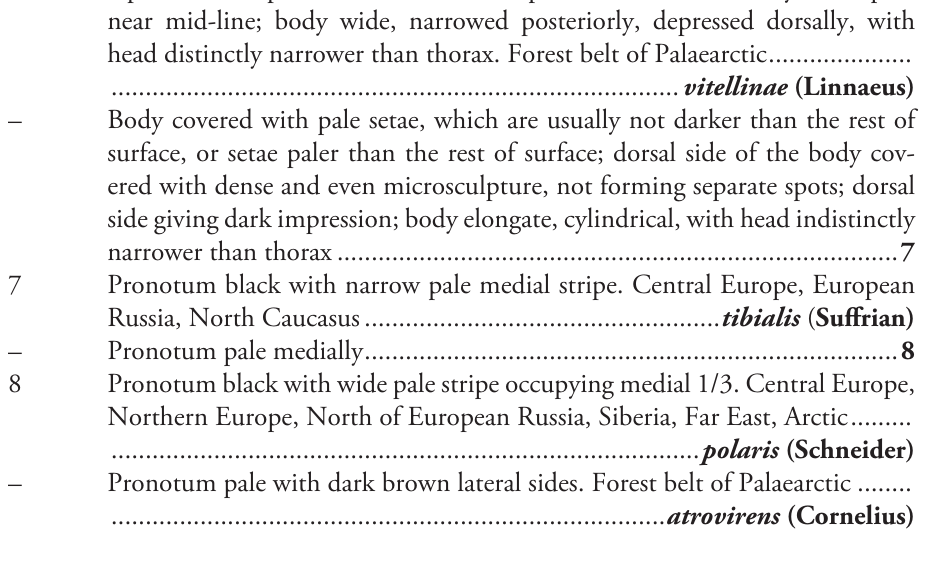
Pronotum black with wide pale stripe occupying medial 1/3. Central